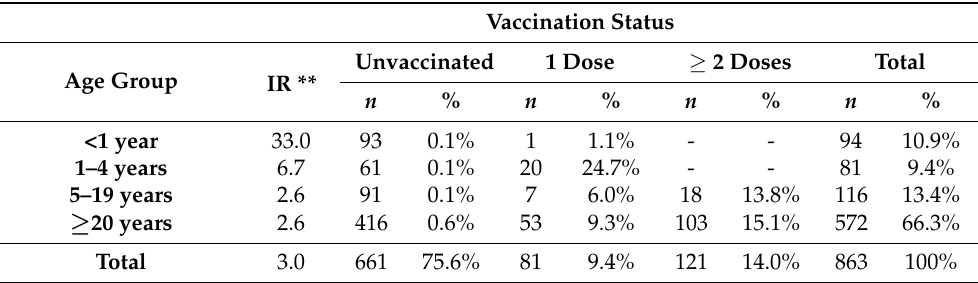
Table 1 . Measles cases with known vaccination status by age group and number of MMR * vaccines. Spain, 2014–2020 .